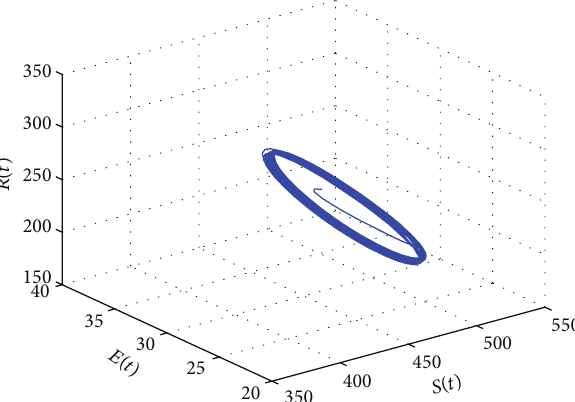
Figure 16: The phase plot of the states 𝑅 , 𝑆 , and 𝐸 for 𝜏 1 = 8.4500 > 𝜏 ∗ = 3 7.8533 = 𝜏 ∗ 1 and 2